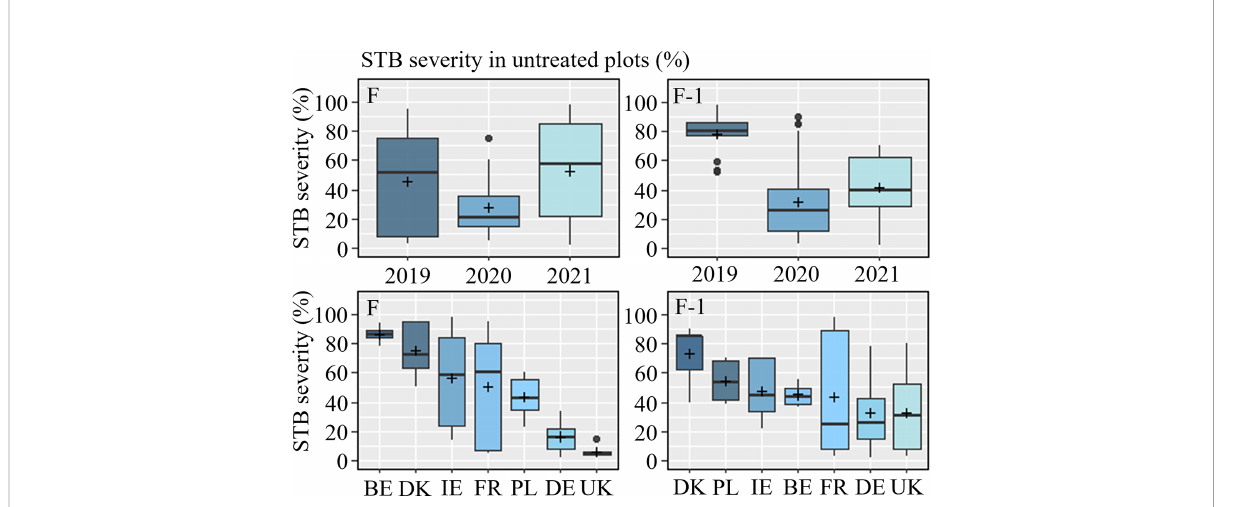
FIGURE 2 Septoria tritici blotch (STB) severity in untreated plots (%) on fl ag leaves (F) (left) and fl ag leaf minus one (F-1) (right) from 2019-2021, sorted by year (top) and country (bottom). The line inside the boxes indicates the median and ‘ + ’ indicates the